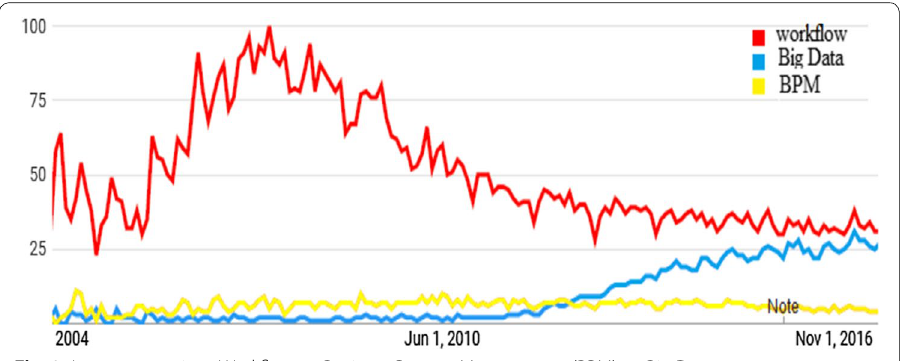
Fig. 2 Interest over time. Workflow vs. Business Process Management (BPM) vs. Big